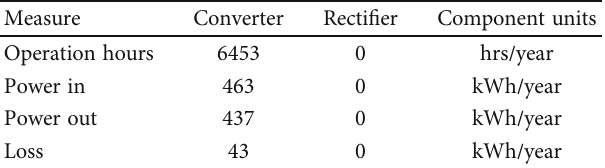
Table 2: Yearly losses in electrical power in a stand-alone